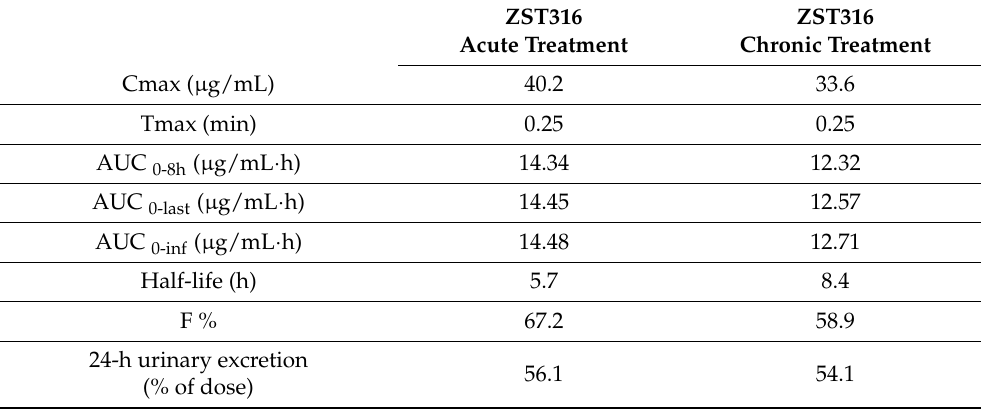
Figure 8. Comparison of ZST316 plasma decay curves after acute oral, intravenous, and intraperi- toneal administration and chronic intraperitoneal administration. Table 8. Pharmacokinetic parameters and urinary elimination of ZST316 after acute and chronic intraperitoneal